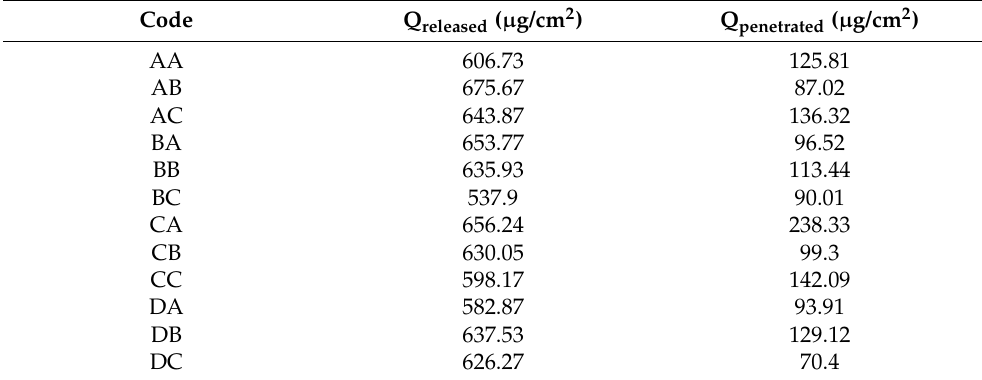
Table 3. Mean cumulative amount of idebenone released (Q released ) or penetrated into the skin (Q penetrated ) from lipid nanoparticles after 24 h.